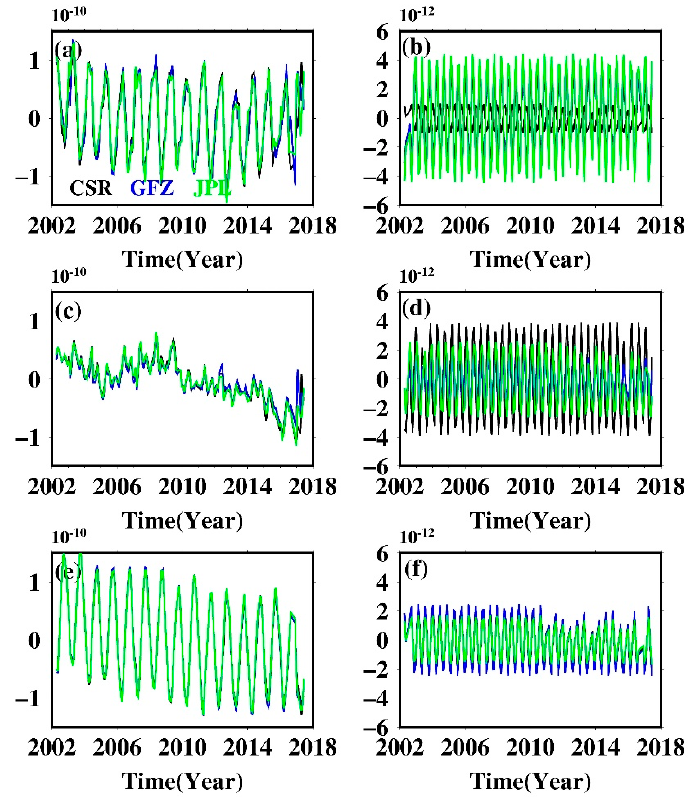
Figure 15. ( a , c , e ) Time series of GRACE low zonal coefficients C 30 , C 40 , and C 50 , respectively; ( b , d , f ) the fitted S 2 aliasing series from C 30 , C 40 , and C 50 , respectively.